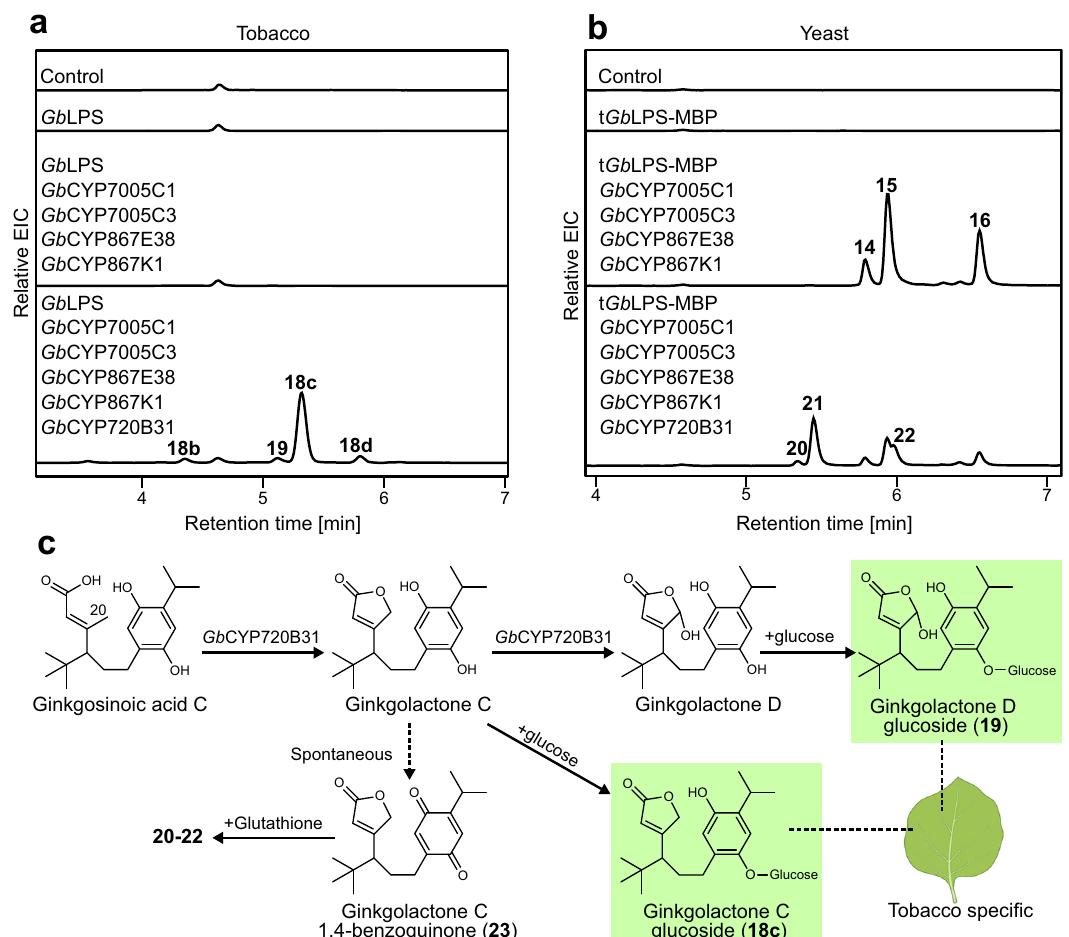
Fig.4|The fi rstlactoneringtowardsginkgolidebiosynthesisisgeneratedfrom the activity of Gb CYP720B31. a LC – HRMS analysis of tobacco leaf extracts expressing Gb LPS and the combinations of CYPcandidates are shownin the panel. ThechromatogramsshownareEICs(positivemode)forthe m / z valuesof333.2062 and331.1904,eachwithawindowof±0.05. b LC – HRMSanalysisofyeastterpenoids extracts from strains expressing Sp GGPPS7, Sc tHMGR, Gb LPS, Gb POR2 and the combinations of CYP candidates shown in the panel. The chromatograms shown areextractedionchromatograms(EICs,positivemode)forthe m / z values636.2581; 638.2751, and 640.2890, each with a window of ±0.05. c Proposed biosynthetic